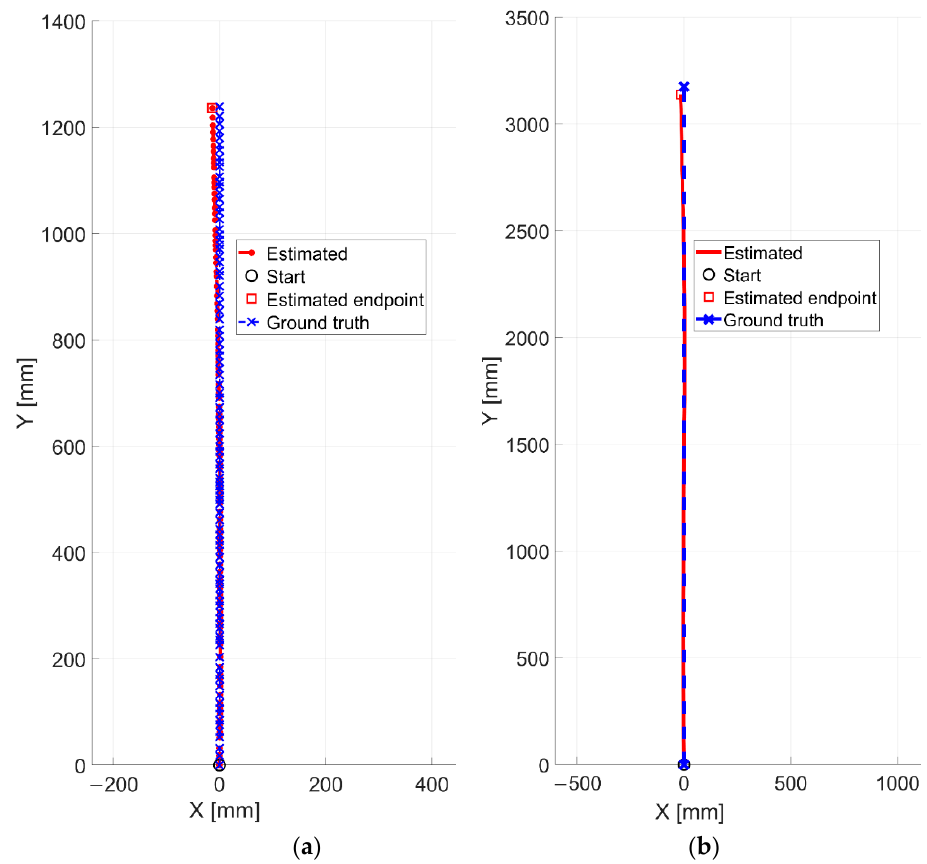
Figure 17. Estimated positions (in red) compared with the ground truth (in blue). The outcomes are related to the experiments ( a ) V and ( b ) VI.